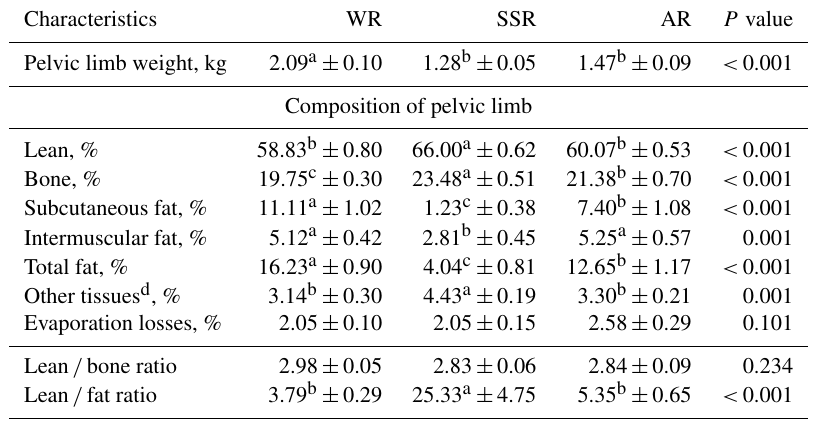
Table 3. Means ± SE for pelvic limb composition of lambs reared in different seasons.